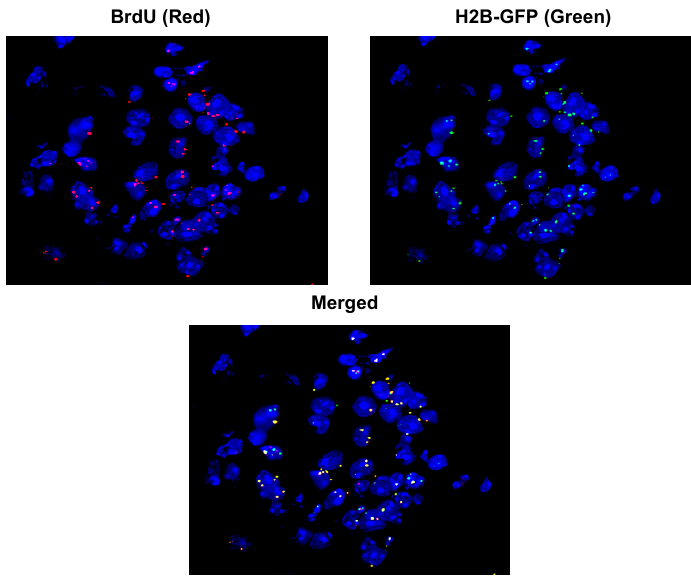
Figure 6. Detection of numerous fluorescent cfCh signals in nuclei of brain cells of mice following intravenous injection of fluorescently dually labelled MDA-MB-231 human breast cancer cells. MDA-MB-231 cells were dually labelled in their DNA with BrdU and in their histone H2B with CellLight ® Histone 2B GFP as described in [84]. One hundred thousand cells were injected intravenously, and animals were sacrificed after 72 h; sections of brain were examined by fluorescent microscopy as described in reference [64]. Magnification x60. (Unpublished data from authors’ lab).